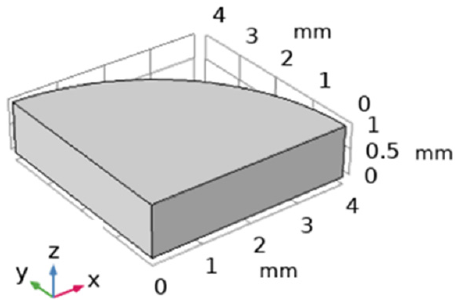
Figure 1. The model of cylindrical silicon in model 1.